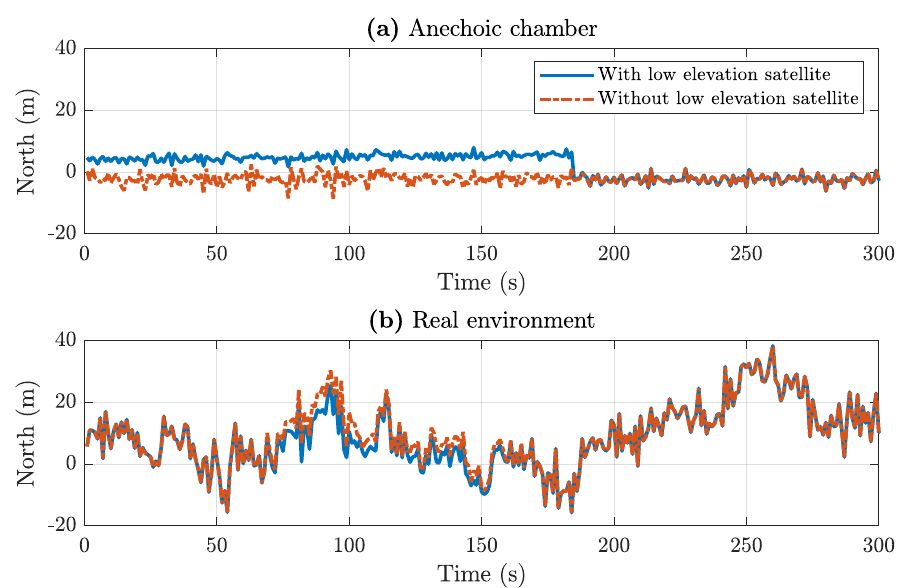
Figure 15. Comparison of the positioning results in controlled ( a ) and real ( b ) environment in the presence and in the absence of bad-quality measurements.